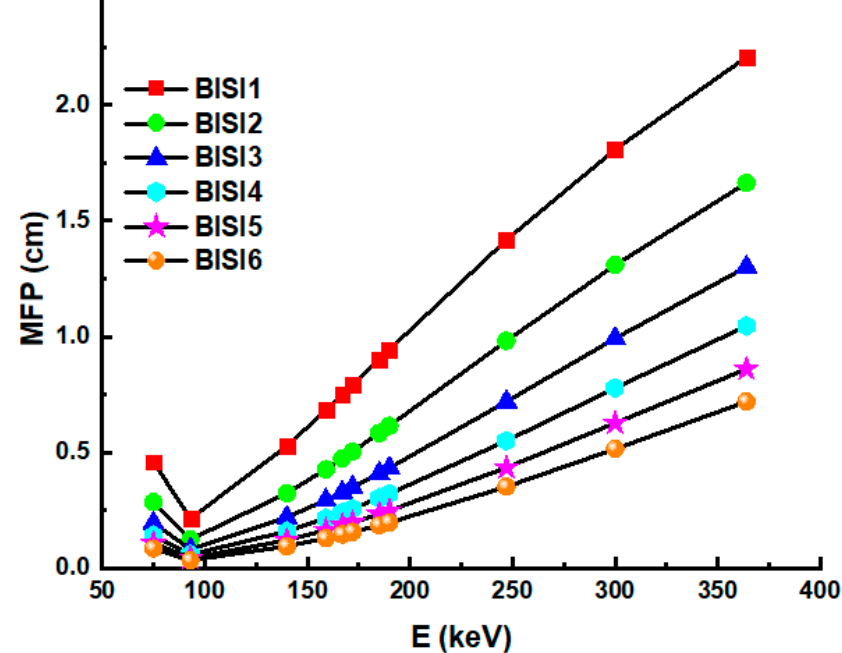
Figure 6. Mean free path (MFP) values as a function of photon energy of glass samples.